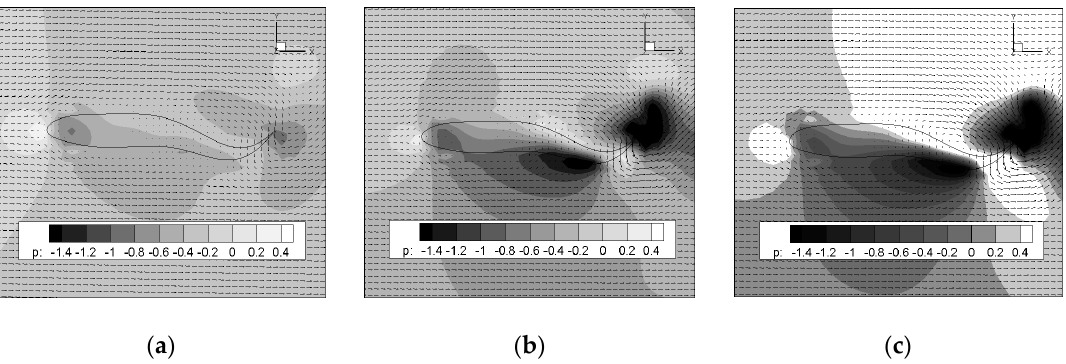
Figure 5. Pressure contours and velocity distributions in the cross-section plane of hydrofoil with three typical AR values ( a ) AR = 1.0; ( b ) AR = 1.0; and ( c ) AR = 5.0.